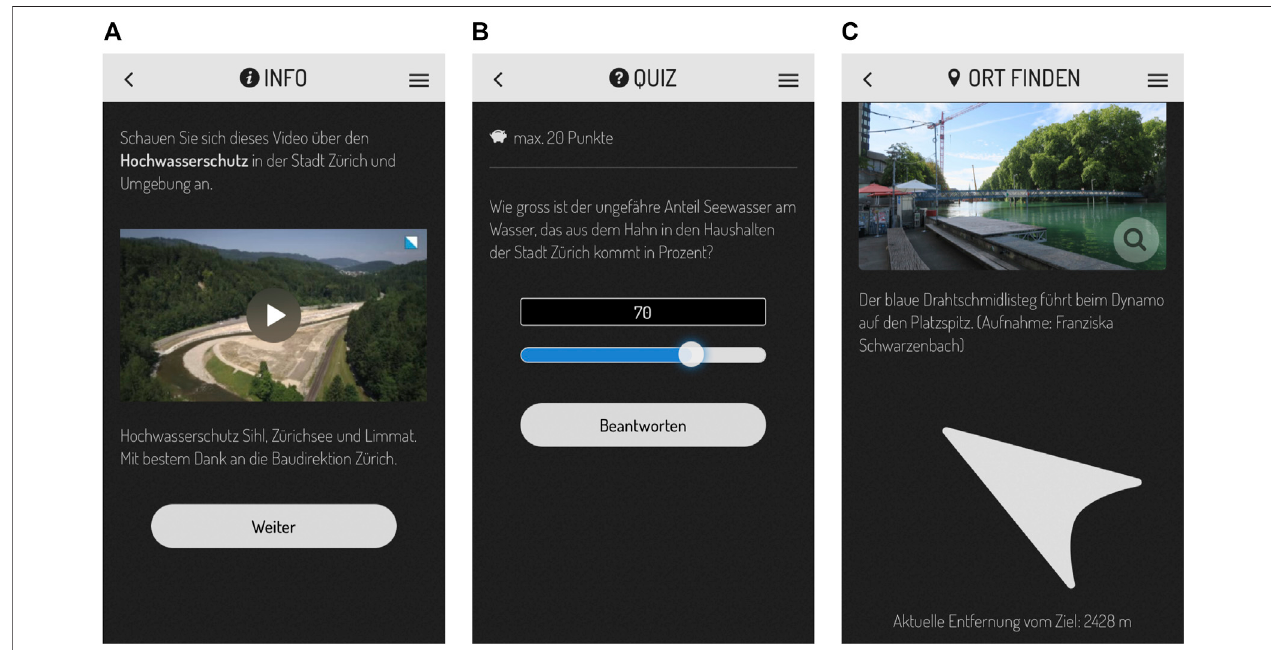
FIGURE 1 | Screenshots of the Water in the city of Zurich excursion in the Actionbound app. (A) : video about fl ood protection measures in the city of Zurich (translation: “ Watchthisvideoabout fl oodprotectioninthecityofZurichandthesurroundingarea. ” ). (B) : “ Numberslider ” foraquestionaboutdrinkingwater(translation: “ WhatistheapproximatepercentageoflakewaterthatcomesoutofthetapinhouseholdsinthecityofZurich? ” ). (C) :Picture,arrowanddistancetothenextstoponthe excursion (translation: “ To reach the ‘ Platzspitz ’ , cross the blue ‘ Drahtschmidlisteg ’ close to the ‘ Dynamo ’ club. ”